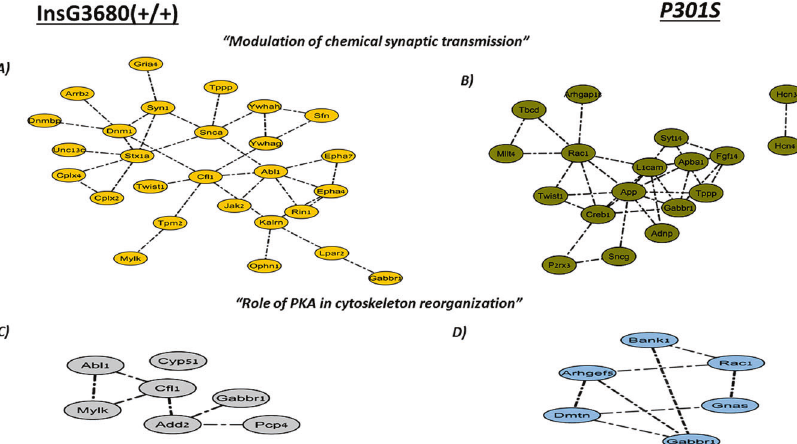
Fig. 3 Clustering analysis of the SNOed proteins in ASD and AD mouse models. “ Modulation of chemical synaptic transmission ” cluster was enriched in A ASD and B AD, and the “ role of PKA in cytoskeleton reorganization ” cluster was enriched in C ASD and D